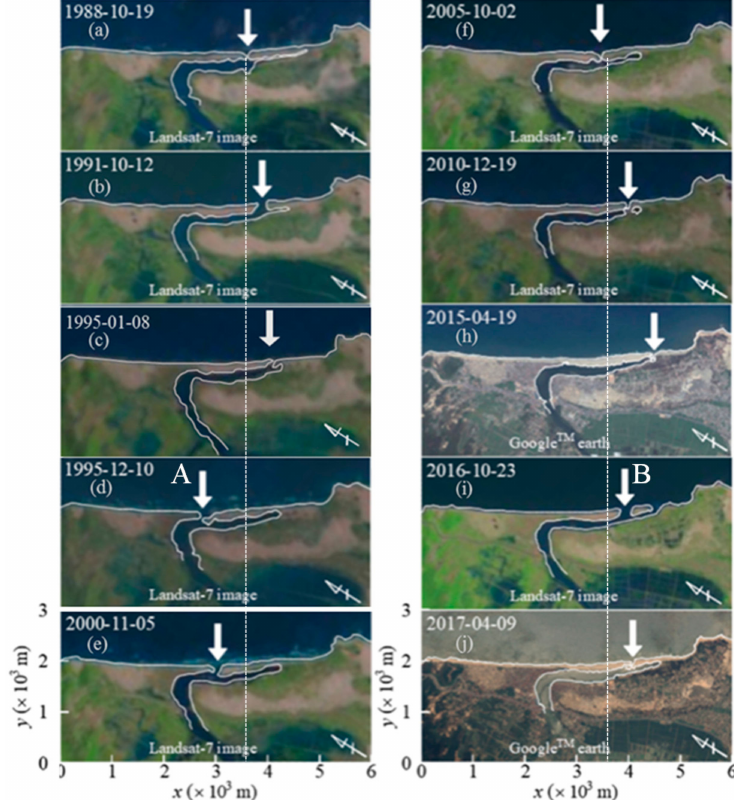
Figure 6. The selected satellite images of the long-term morphological changes at the Ly Hoa Inlet, Quang Binh province from ( a – j ) 19 October 1988 to 9 April